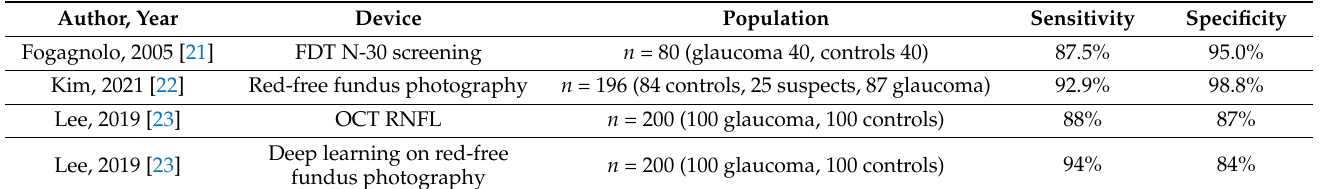
Table 4. Sensitivity and specificity of screening devices for glaucoma